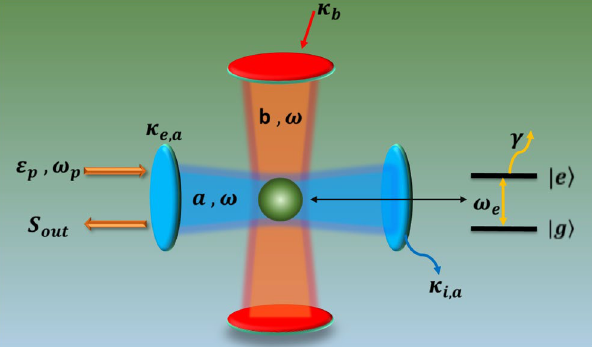
Figure 1. Schematic illustration of the PT -symmetric trimer system including a horizontal cavity, a vertical cavity and a two-level QE. The horizontal cavity is coherently driven by a weak probe field with the amplitude ε p and the frequency